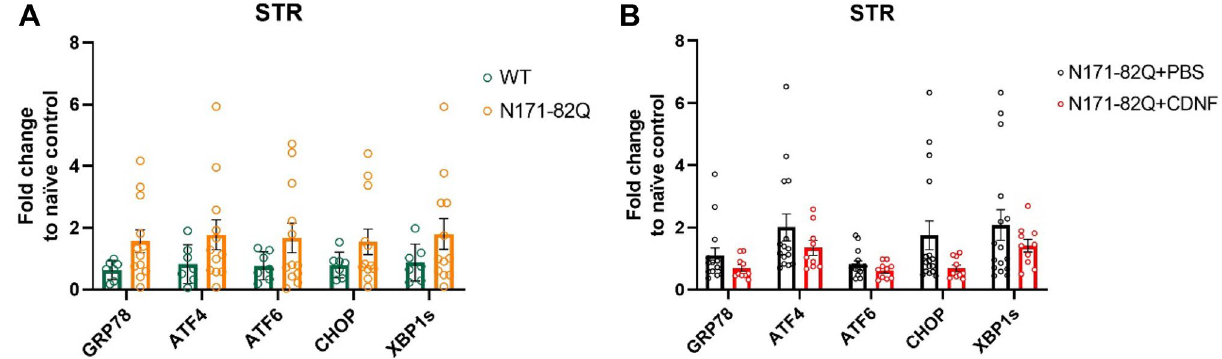
Figure 11. RT-qPCR analysis of ER stress markers in the N171-82Q mouse model. ( A ) ER stress marker levels in the striatum (STR). ( B ) ER stress marker levels in the striatum of CDNF- and PBS- treated mice. Values are the means ± SEMs. Unpaired t-test. N per group =